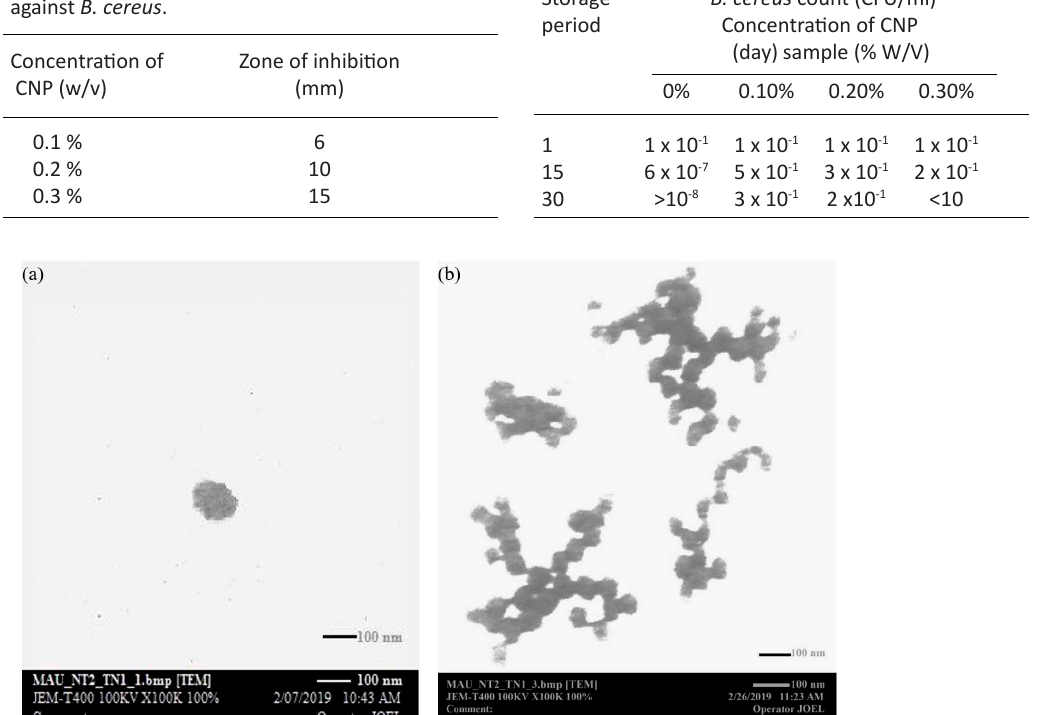
Table 1. The mean of inhibition zones diameter (mm) of three concentrations of chitosan nanoparticles against B. cereus .